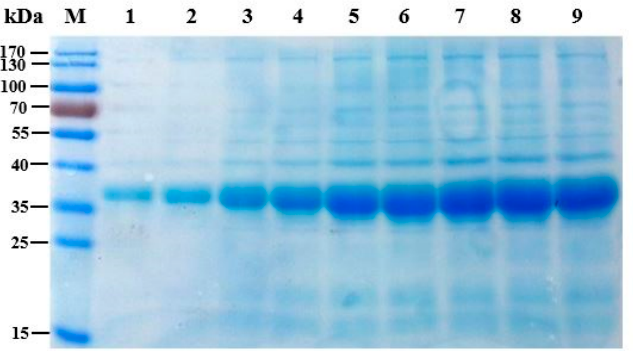
Figure 5 . SDS-PAGE analysis ofsupernatant obtained during culture in a 10 L fermenter; raw